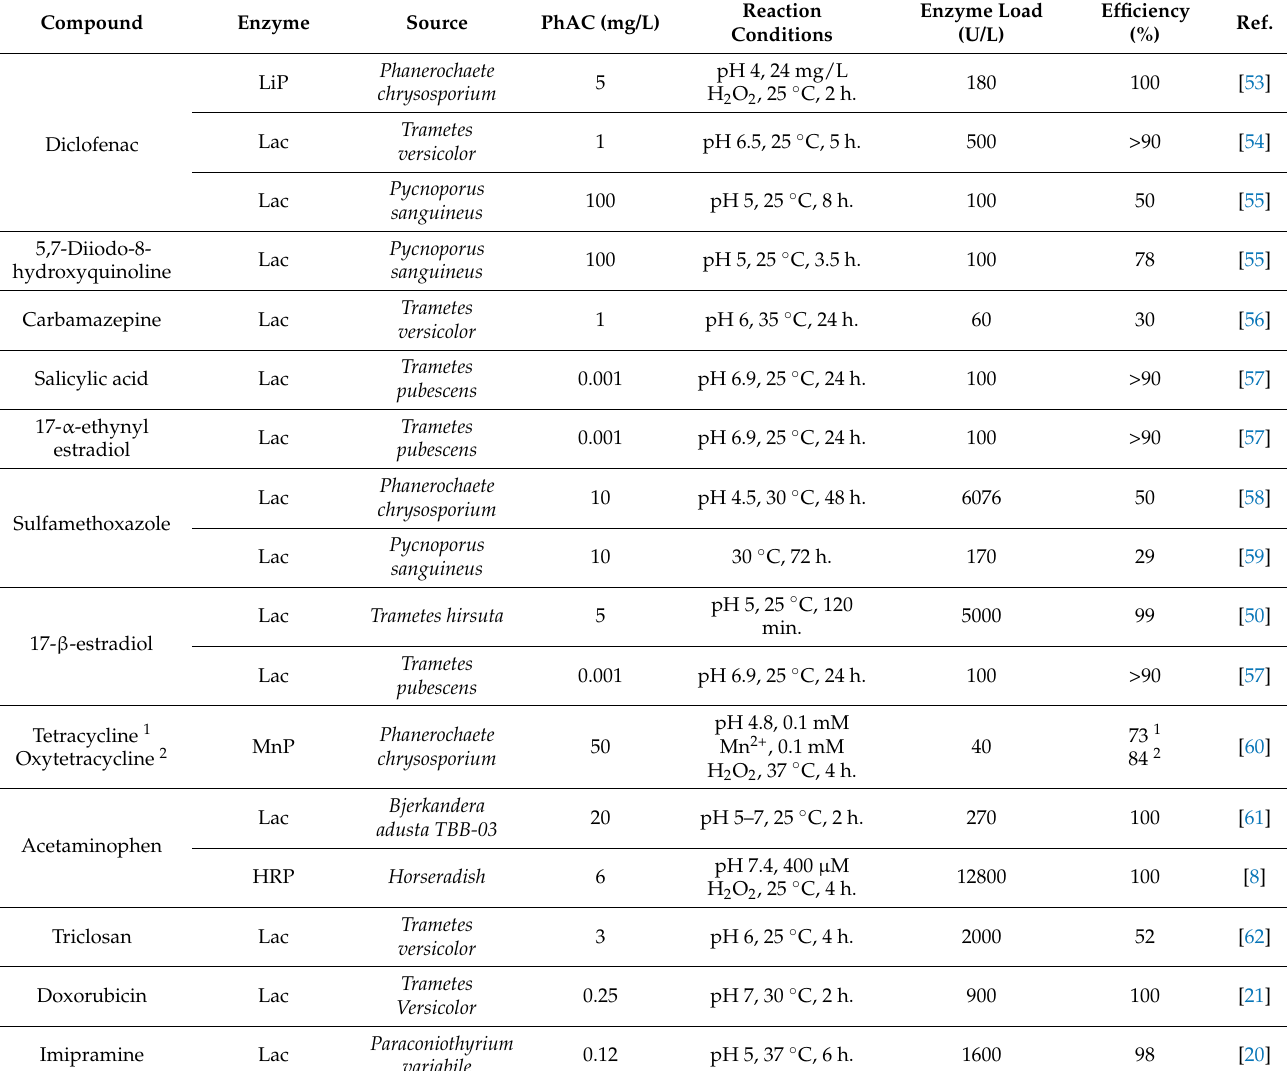
Table 1. Examples of biodegradation of pharmaceutical micropollutants by